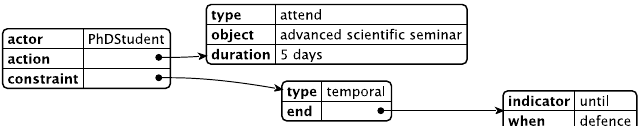
Figure 3: “Advanced scientific seminars” regulation represented through the generic rule